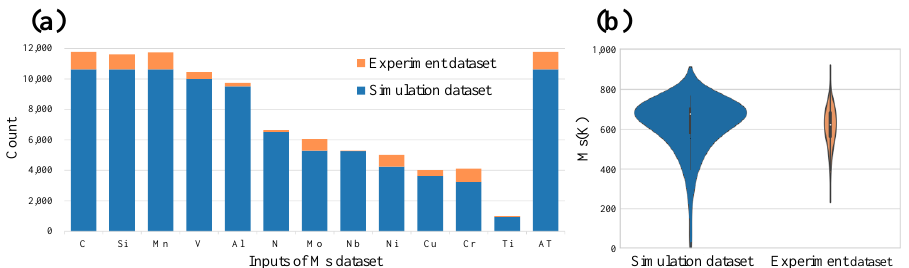
Figure 3. Statistics of Ms simulation dataset. ( a ) The occurrence counts of elements in the Ms simulation dataset and experiment dataset. ( b ) Violin plot of output variable of Ms simulation dataset and experiment